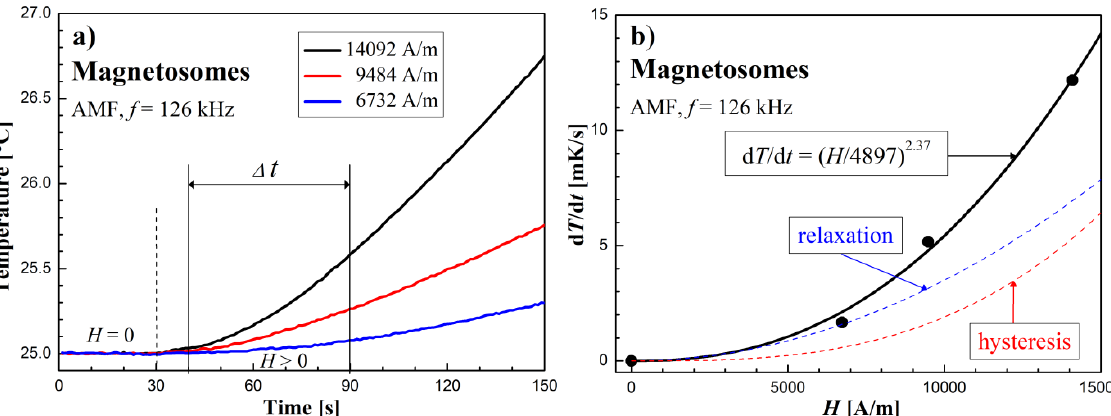
Figure 9. Time courses of temperature changes in the Dextran FF sample ( a ) and ( b ) d T /d t values depending on the amplitude of the magnetic field strength H in the AMF at the frequency f = 115 kHz.